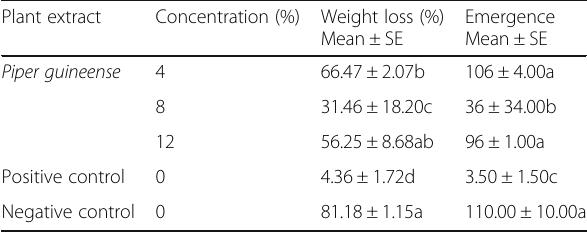
Table 1 Pesticidal effect of ethanolic extract of P. guineense on emergence and weight loss